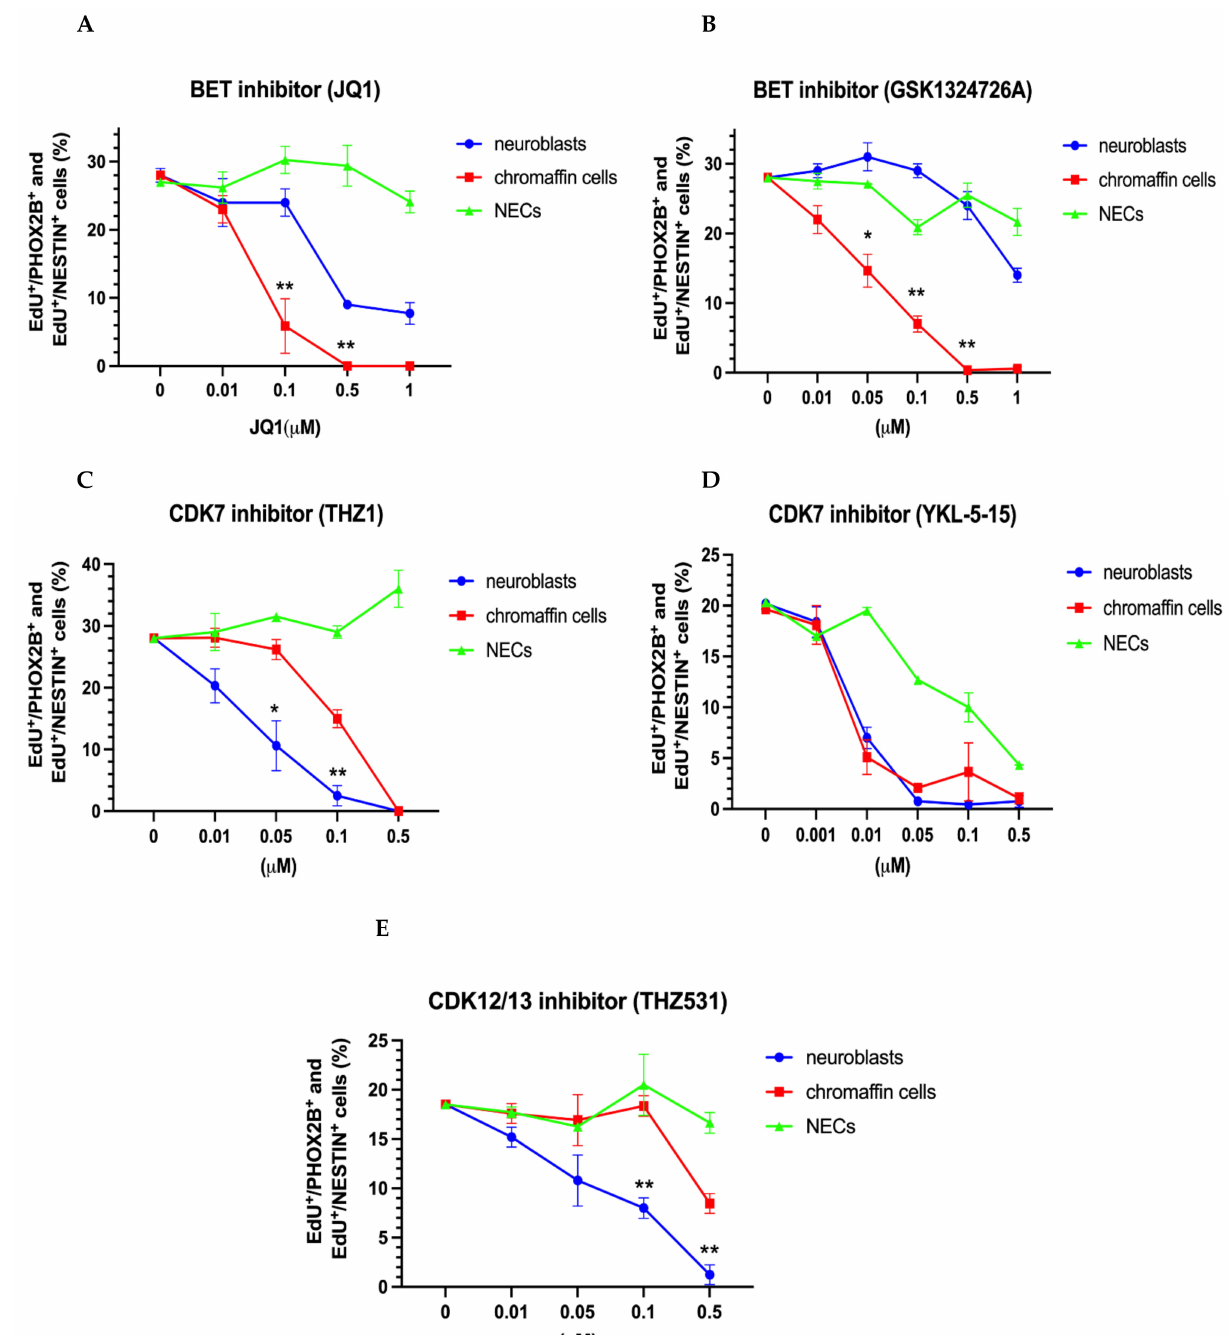
Figure 7. Effect of BET inhibitors JQ1 and GSK1324726A and of CDK inhibitors THZ1, YKL-5-15, and THZ531 on the proliferation of chromaffin cells, neuroblasts, and NESTIN-expressing cells (NECs). Dose–response curves are shown for the BET inhibitors JQ1 ( A ) and CSK1324726A ( B ), CDK7 inhibitors THZ1 ( C ) and YKL-5-15 ( D ) and the CDK12/13 inhibitor THZ531 ( E ), Data represent the mean ± s.e.m. of at least three independent experiments. Significant differences marked by * and ** indicate p -values < 0.05 and <0.01,